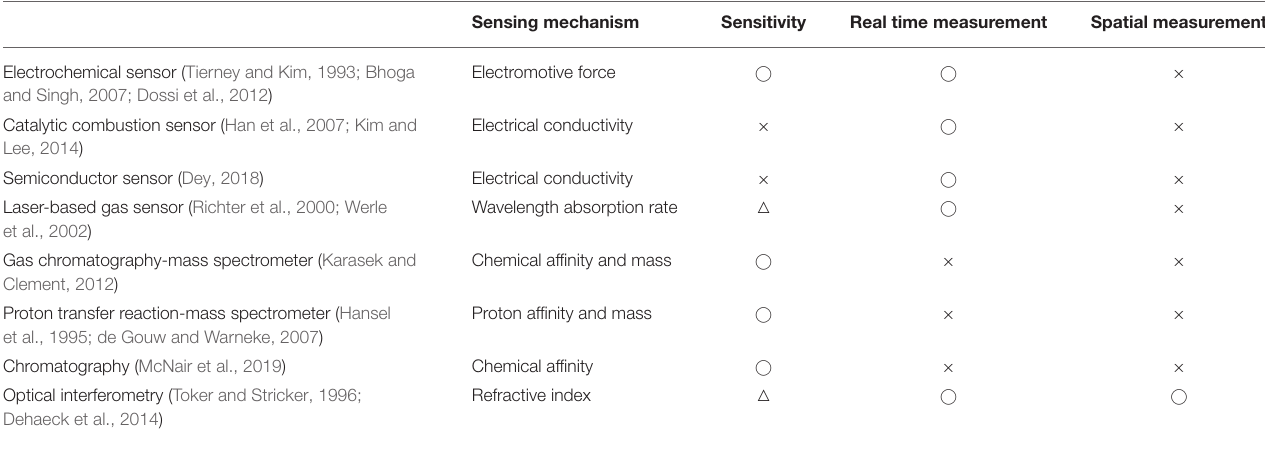
TABLE 1 | Current gas sensing measurement techniques ( (cid:13) : Good, △ : Fair, × :